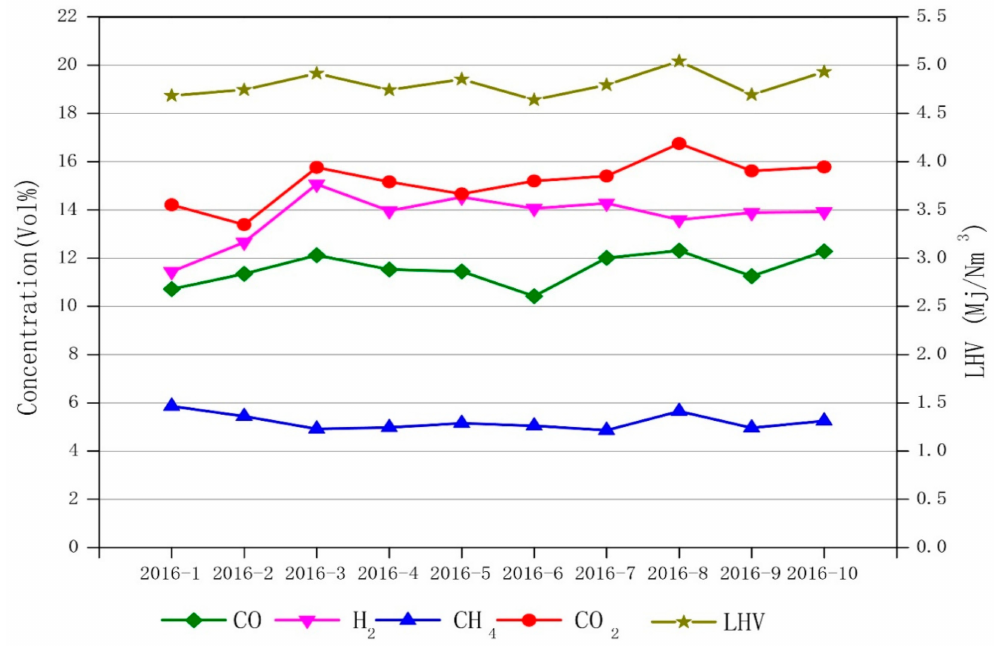
Figure 3. The syngas compositions and low-heat value as a function of